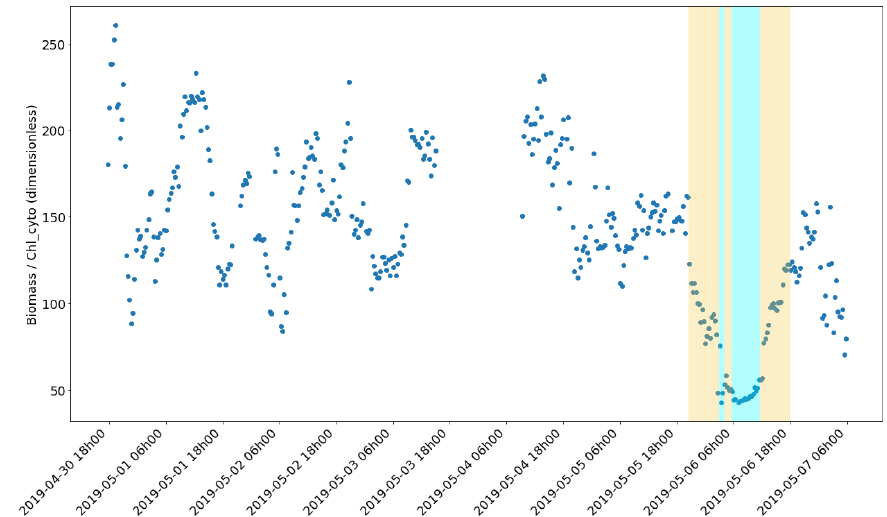
Figure 13. Evolution of the biomass (ngCmL − 1 ) / Chl_cyto (ngmL − 1 ) ratio through the cruise. The yellow and cyan colour spans corre- spond to the water masses in Fig.